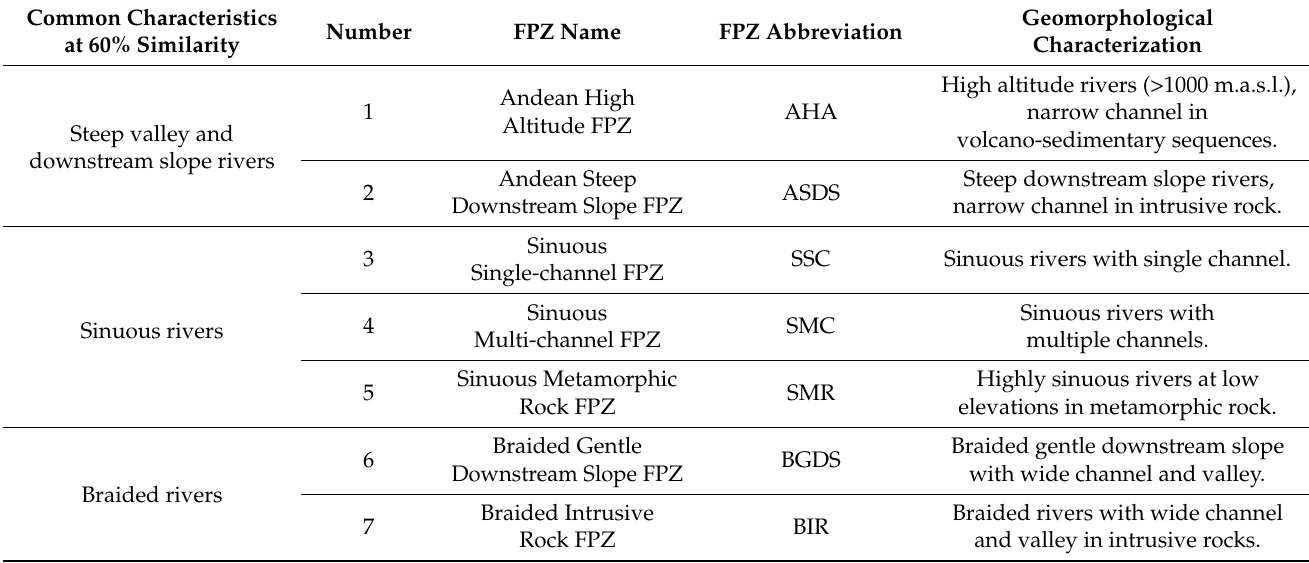
Table 3. Main characteristics of the riverine Functional Process Zones identified for eleven river